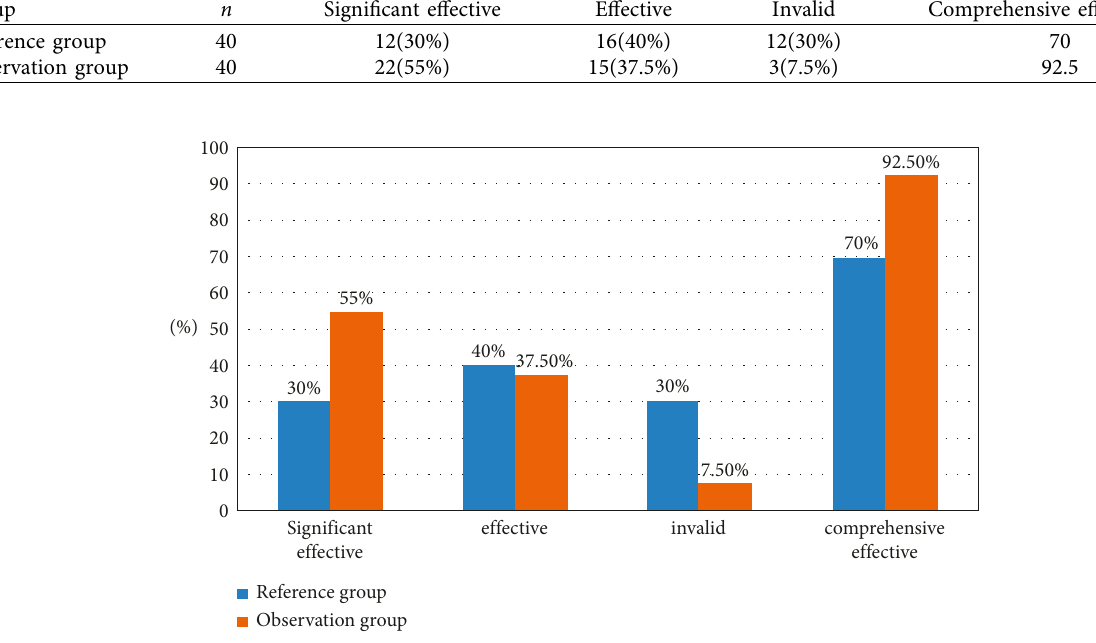
Figure 5: Visualization of treatment effectiveness (%).